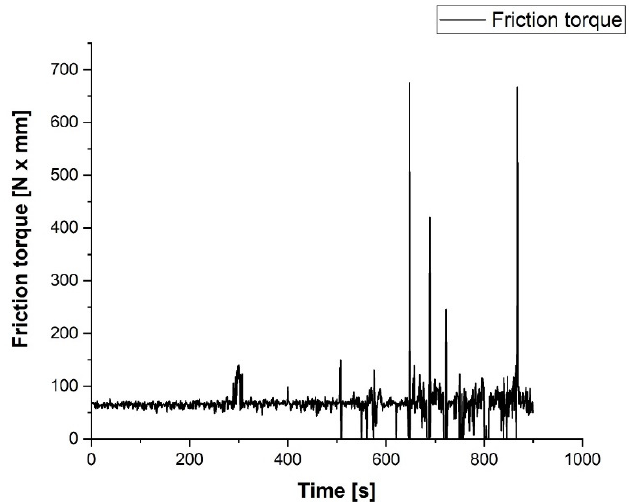
Figure 8. The friction test results performed on the AMSLER